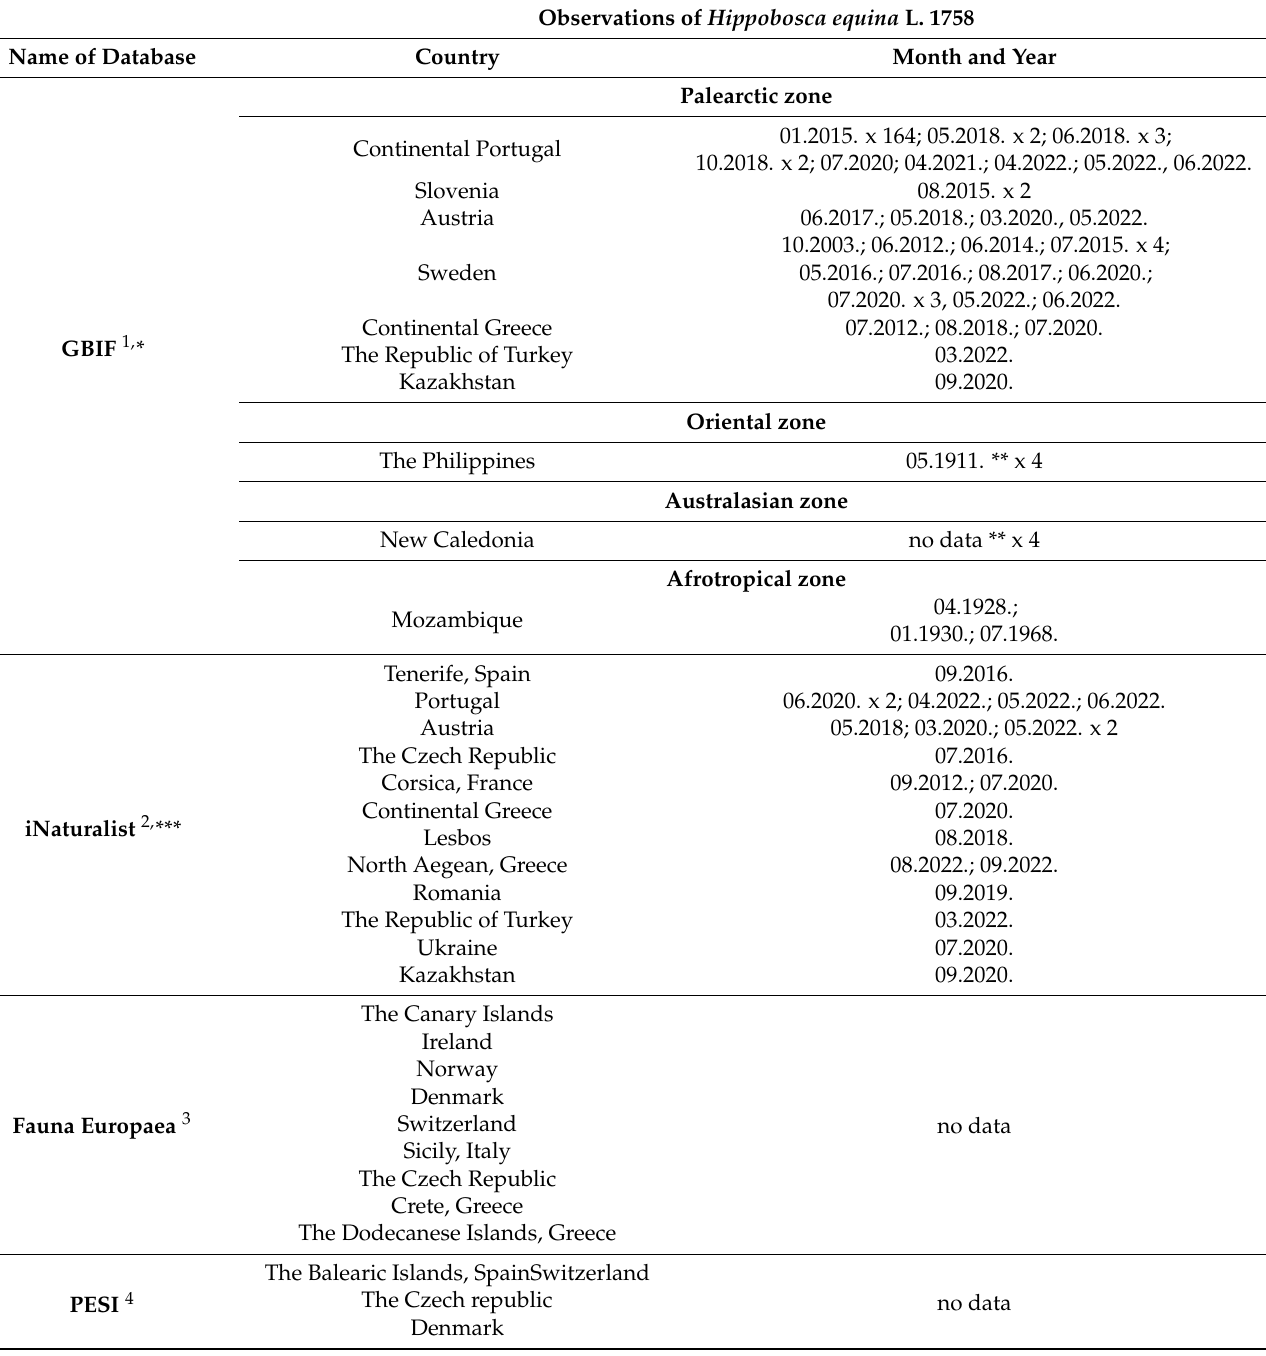
Table 2. Records confirming Hippobosca equina occurrence according to the internet biodiversity databases (only in countries where the occurrence of H. equina was not confirmed by scientific papers or national